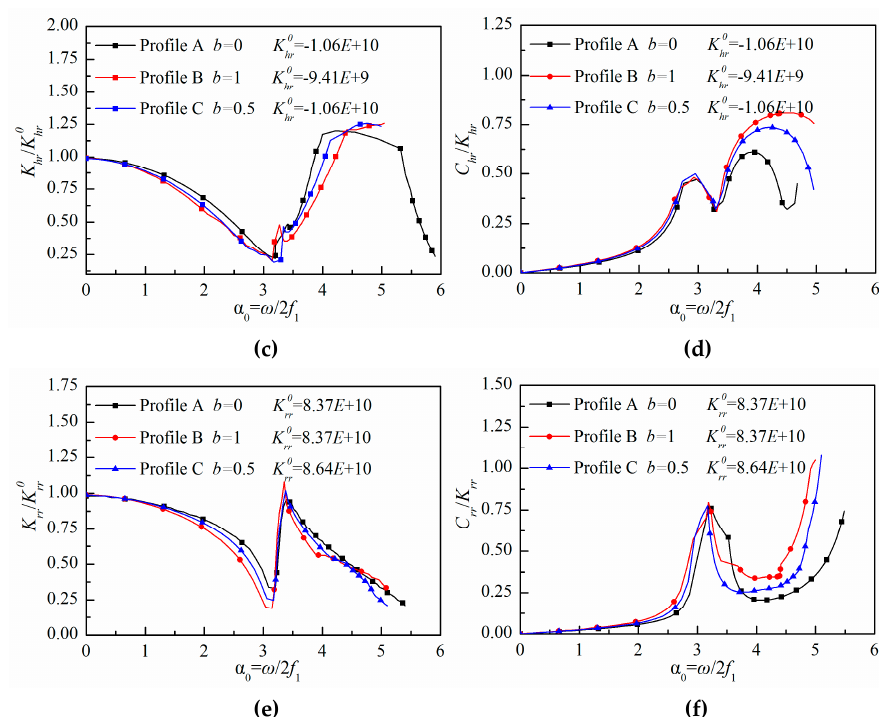
Figure 14. Variation of three dynamic stiffness coefficients with respect to the dimensionless frequency under the effect of the multi-layer soil stiffness: ( a ) Horizontal stiffness coefficient; ( b ) horizontal damping coefficient; ( c ) coupling stiffness coefficient; ( d ) coupling damping coefficient; ( e ) rocking stiffness coefficient; ( f ) rocking damping coefficient.